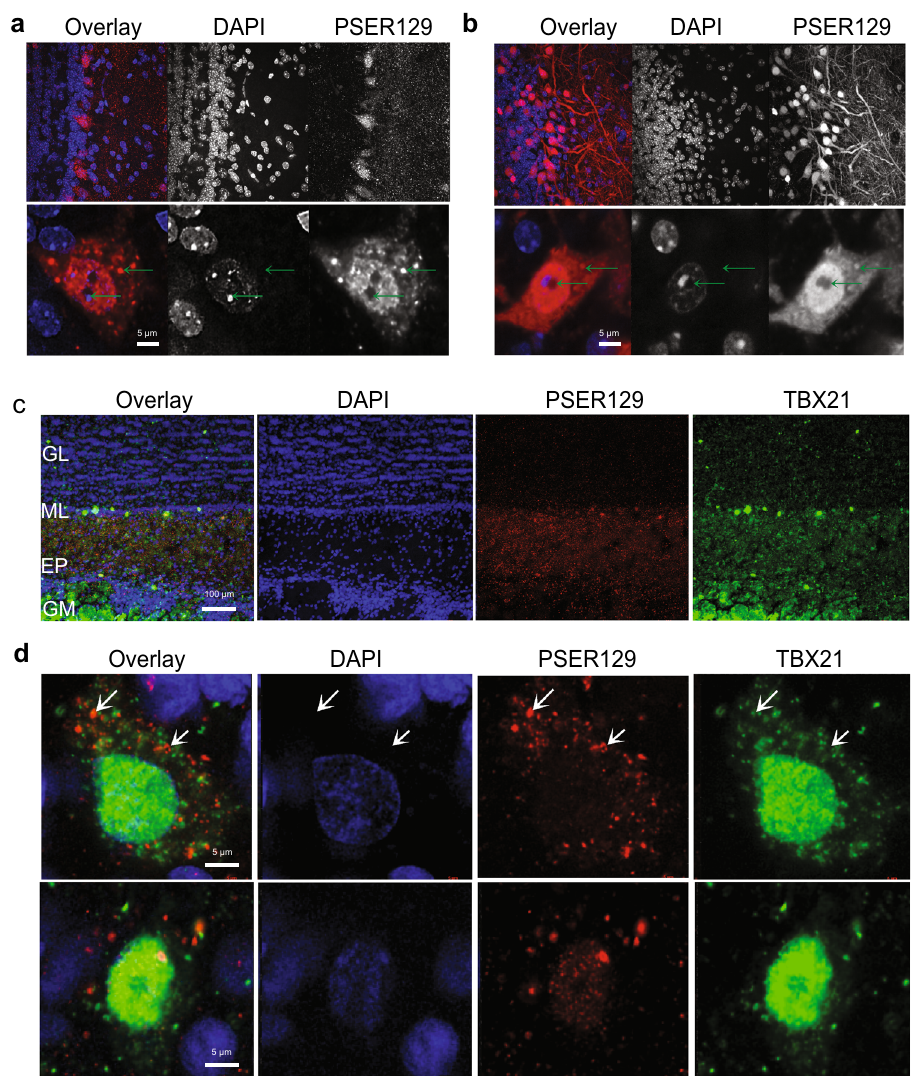
Fig. 2 Localization and intracellular distribution of PSER129 in the non-diseased OB. a PSER129 was fl uorescently labeled using TSA in WT mice. Tissues were counterstained with DAPI. Representative images showing the distribution of PSER129 in the OB. b Non-pathology bearing M83 mice labeled for PSER129. Non-human primate OB was dual-labeled for PSER129 and mitral cell marker TBX21. c Low magni fi cation confocal images showing regional distribution in non-human primate OB. d High-magni fi cation confocal images showing PSER129 puncta in TBX21-positive mitral cell. Green arrows denote intracellular punctate structures, both perinuclear and nuclear. WT mice n = 5, M83 mice n = 2, non-human primates =